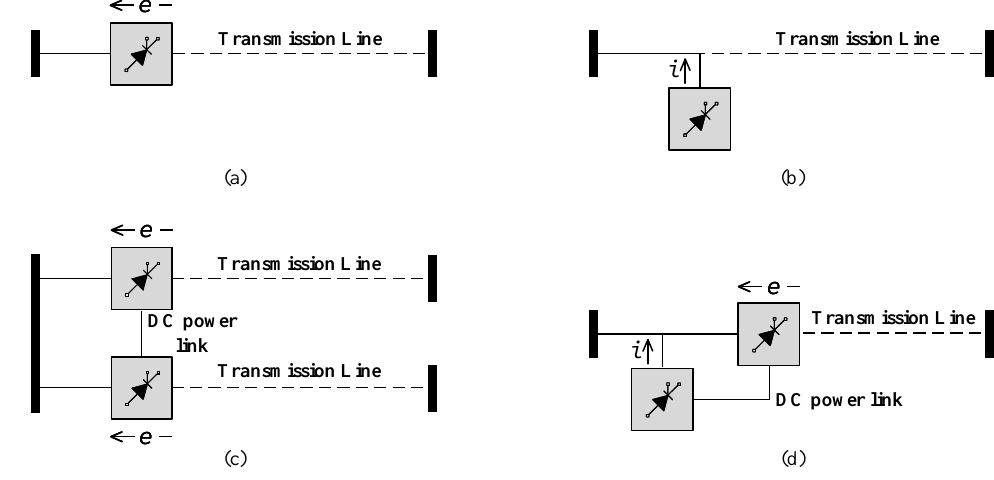
Figure 1. Different kinds of FACTS devices based on their connection type to the power system. ( a ) series; ( b ) shunt; ( c ) series-series; and ( d ) series-shunt.